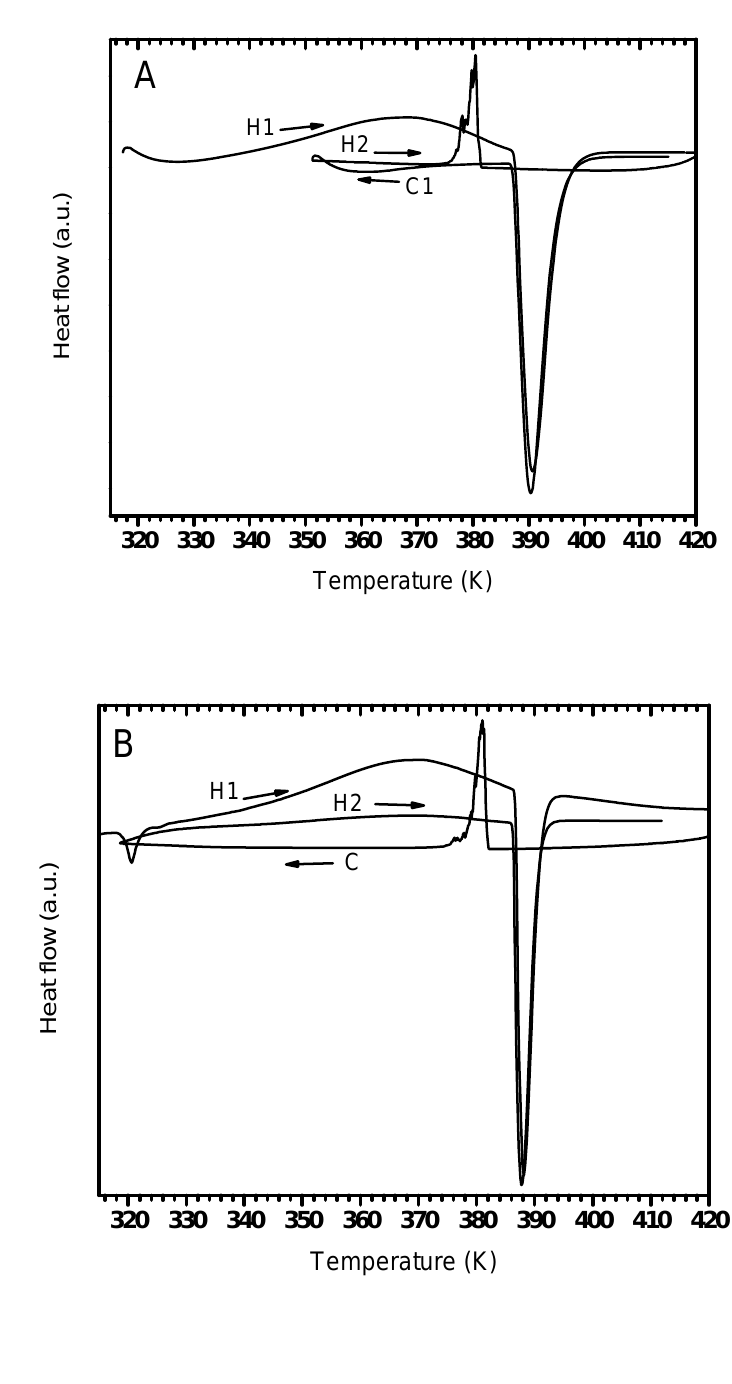
Figure 2. Scanning PDSC traces under argon (A) and 2 bar hydrogen pressure (B) of unmilled LiBH . H1: first heating run; C: first cooling; H2: second heating run. Heating 4 and cooling rates: 20 K min –1